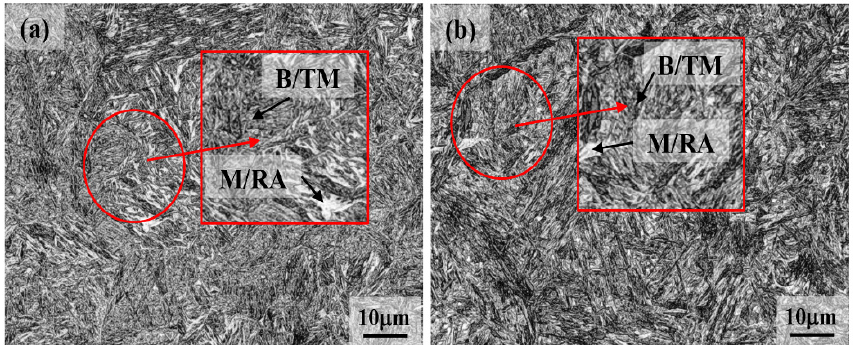
Figure 9. Micrographs recorded on Q&P samples were quenched at ( a ) 250 °C and ( b ) 200 °C and held for 1 h isothermal holding time. TM, B and M/RA represent tempered martensite, bainite and martensite–retained austenite islands,